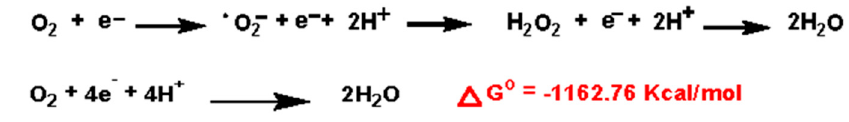
• O − , H 2 2 O 2 and H 2